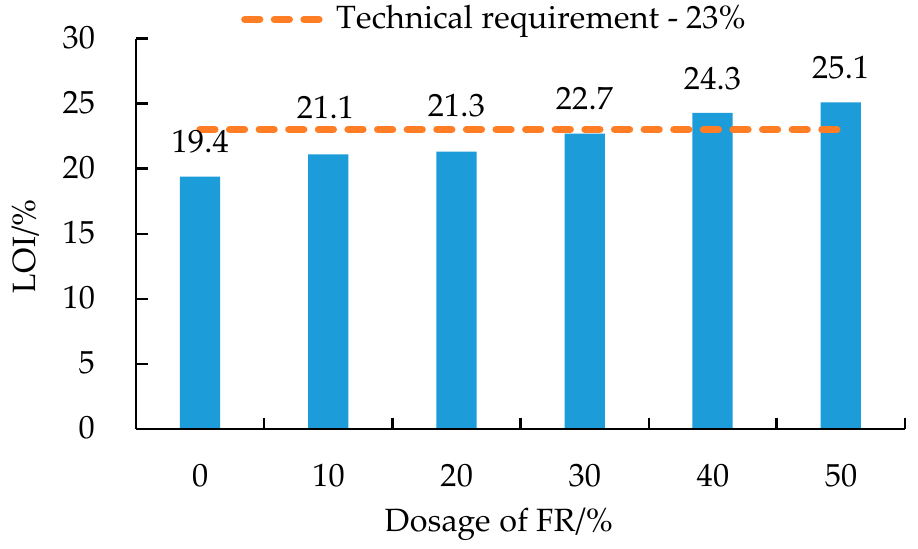
Figure 1. Limiting oxygen index (LOI) results of FRA.